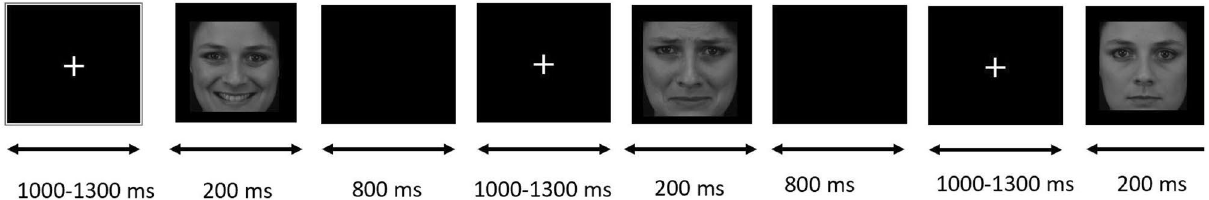
Figure 1. Timeline of events during the session. Note: ms milliseconds. The images are an example of faces of each emotion extracted from the Karolinska Emotional Directed Faces database. Image ID: AF01DIS, AF01ANS, AF01NES. Copyright: https:// kdef. se/ home/ using% 20and% 20pub lishi ng% 20kdef% 20and% 20akd ef.